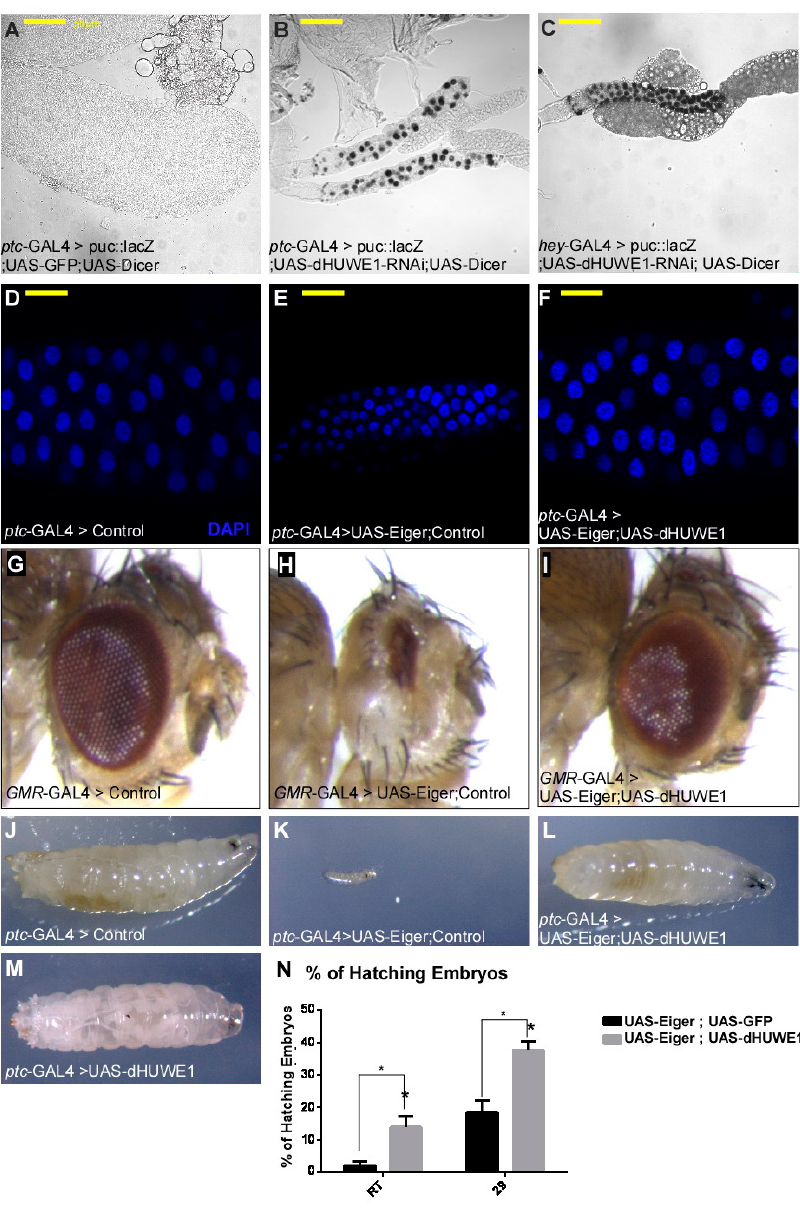
Figure 4. dHUWE1 inhibits JNK signaling and antagonizes the ligand Eiger. ( A–C ) Activation of the JNK pathway puc 69 ::LacZ-reporter (puc::LacZ, black staining) in control ( A ), or UAS dHUWE1-RNAi under the control of ptc -Gal4 ( B ) or hey -Gal4 ( C ). ( D–N ) dHUWE1 antagonizes Eiger. Expression of UAS-Eiger results in a small salivary gland ( D compared to E ), and small eyes ( G compared to H ). Co-expression of UAS-Eiger with UAS-dHUWE1 suppresses these phenotypes ( F , I ). ( D – F ) Indirect immunofluorescence confocal microscopy images of salivary glands derived from wild-type or the indicated transgenic lines. DAPI marks DNA and scale bar is 50 µ m. ( J – N ) Expression of Eiger results in lethality during early larval stages that is partially restored by co-expression of UAS-dHUWE1. ( J – M ) Representative larval images of the indicated genotypes. ( N ) Quantification of embryonic hatching at indicated temperatures. Expression of UAS-Eiger together with UAS-GFP (control) is shown in black bars, and expression of UAS-Eiger together with UAS-dHUWE1 is shown in gray bars n = 1000 p = 0.0487 (29 °C, 29); p = 0.0426 (Room temperature, RT).